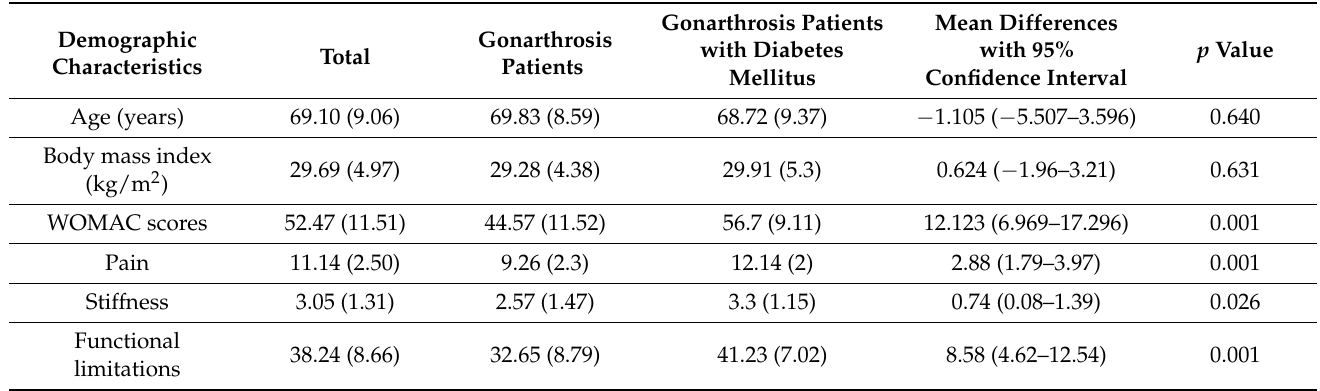
Table 1. Demographic and clinical characteristics (mean ± standard deviation (SD)) ingonarthrosis patients with ( n = 43, females: n = 33, males: n = 10) and without diabetes mellitus ( n = 23, females: n = 20; males: n = 3).